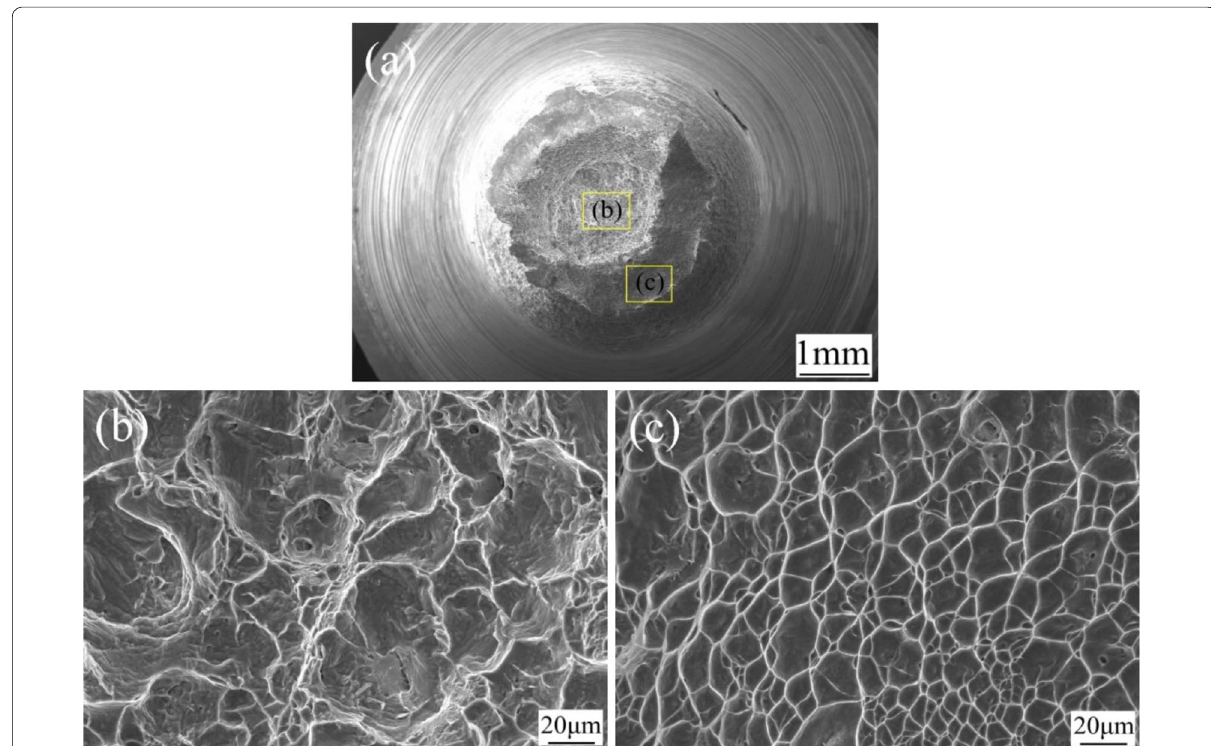
Figure 17 Fracture morphology of the tensile specimen at high temperature of 480 °C test: a Over view, b Center zone of fracture and c Edge zone of